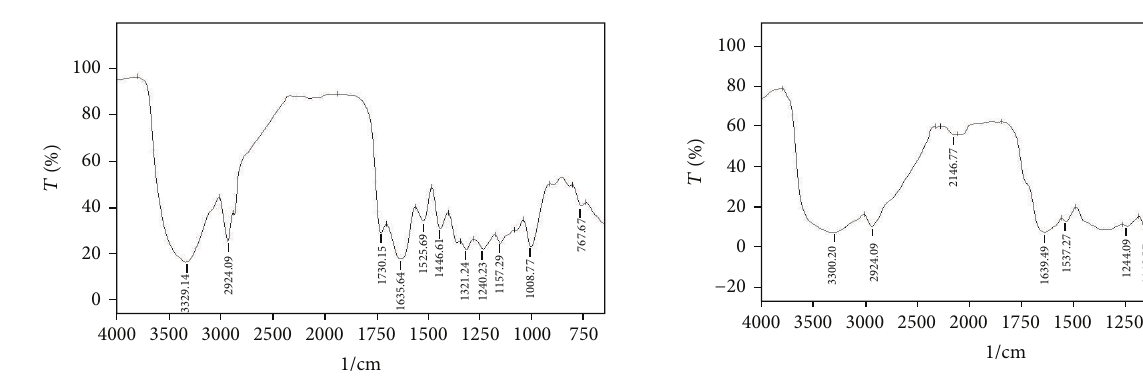
Figure 6: FT-IR spectrum of untreated PP.